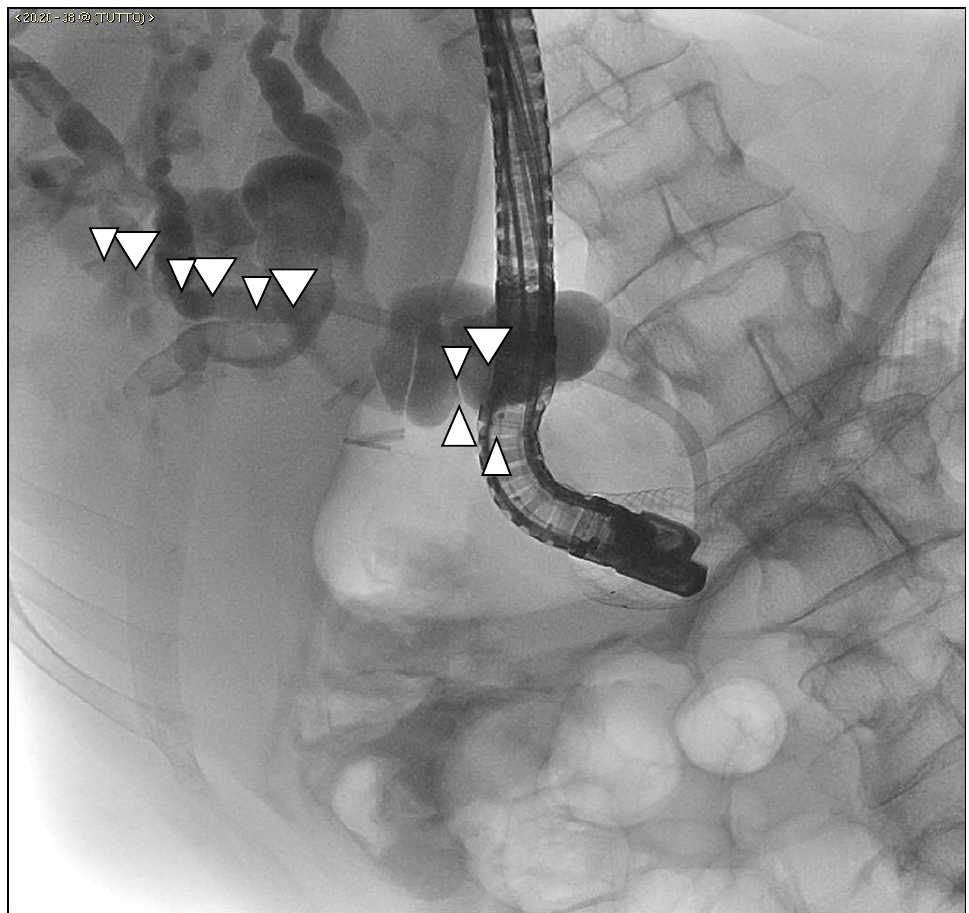
Figure 8. An angioplasty balloon (arrows) is mounted on the guidewire previously brought out by percutaneous retrograde (through the One-Snare device), which here appears already inflated, capable of breaking the stent links and widening the greater papilla-inflated balloon through the biliary duct and the major papilla.